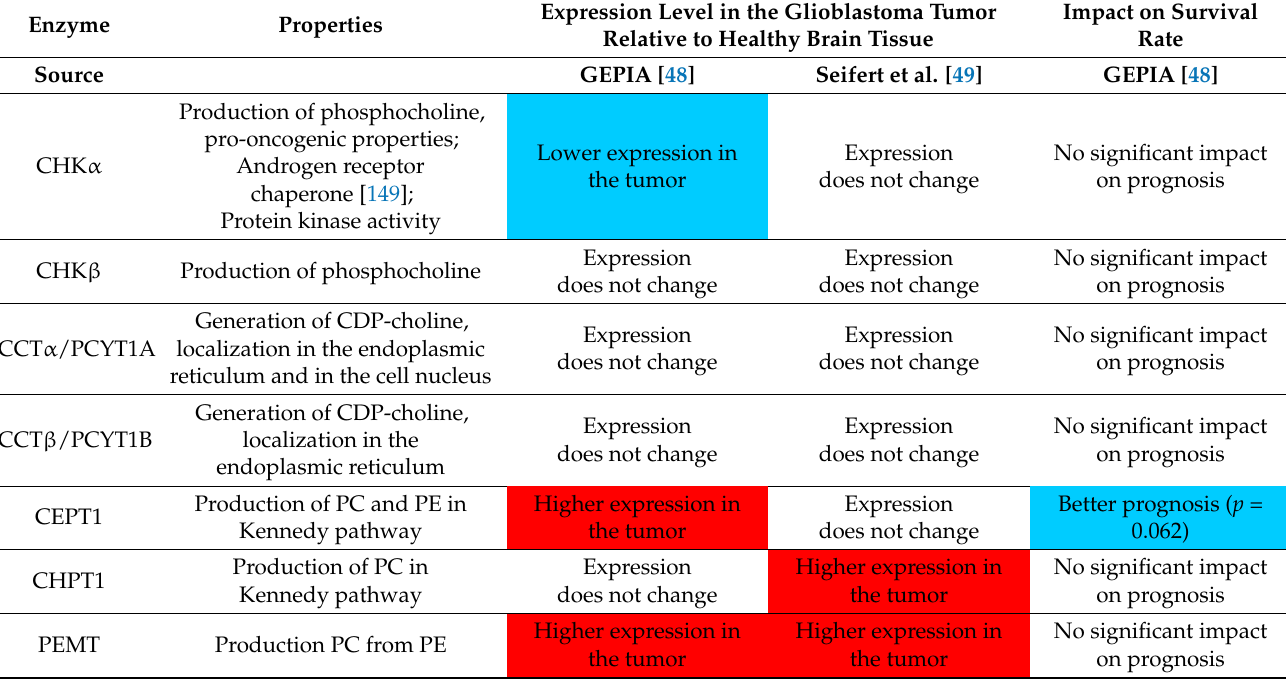
Table 8. Characteristics of enzymes involved in PC